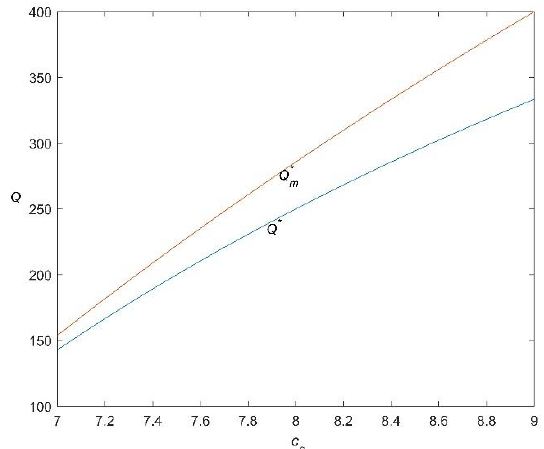
Figure 2. Optimal purchase quantity Q ∗ and Q ∗ m under different spot prices c s